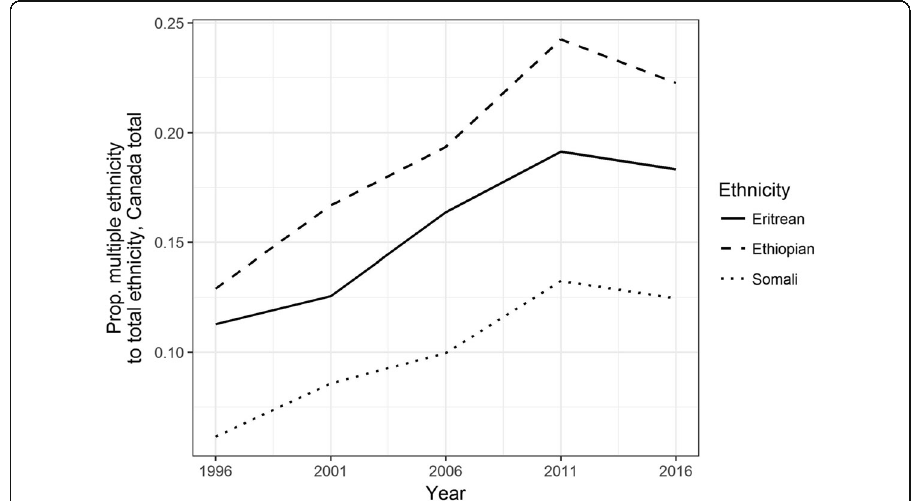
Fig. 8 Proportion of people reporting Eritrean, Ethiopian, and Somali ethnicity who reported multiple